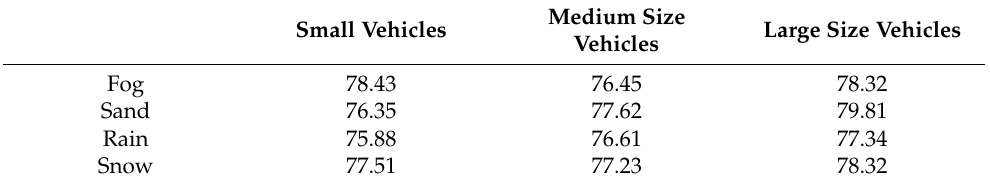
Table 6. Detection of vehicles under different weather conditions with their average precision